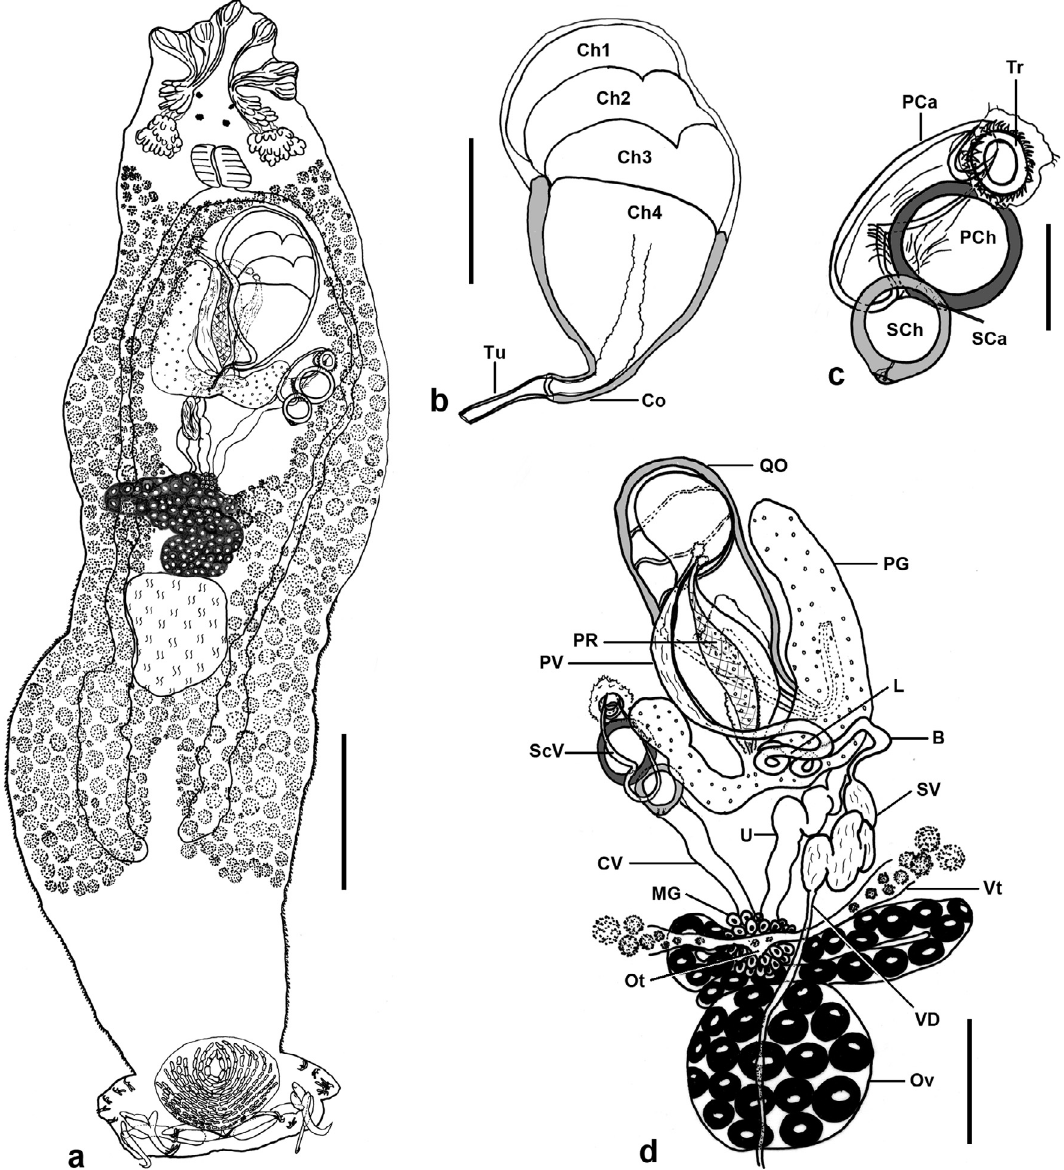
Figure 1. Pseudorhabdosynochus jeanloui n. sp. from Paranthias colonus . a , composite, mainly from holotype, Hoyer, tegumental scales only on edges, ventral view. b , quadriloculate organ, holotype, Hoyer, ventral view. Ch1-4, chambers; Co, cone; Tu, tube. c , sclerotized vagina, ventral view. Tr, trumpet; PCa, primary canal; PCh, primary chamber; SCa, secondary canal; SCh, secondary chamber. d , male and female organs, testis not represented, paratype, carmine, dorsal view. VD, vas deferens; SV, seminal vesicle; B, bend; L, loops; PV, deferent enlarged posterior vesicle; PR, prostatic reservoir; PG, prostatic gland; QO, quadriloculate organ; Ov, ovary; Ot, ootype; Vt, vitelline ducts; MG, Mehlis’s glands; U, uterus; CV, unsclerotized canal from secondary chamber of vagina to ootype; ScV, sclerotized vagina. Scale bars: a, 100 l m; b, d, 40 l m; c, 20 l